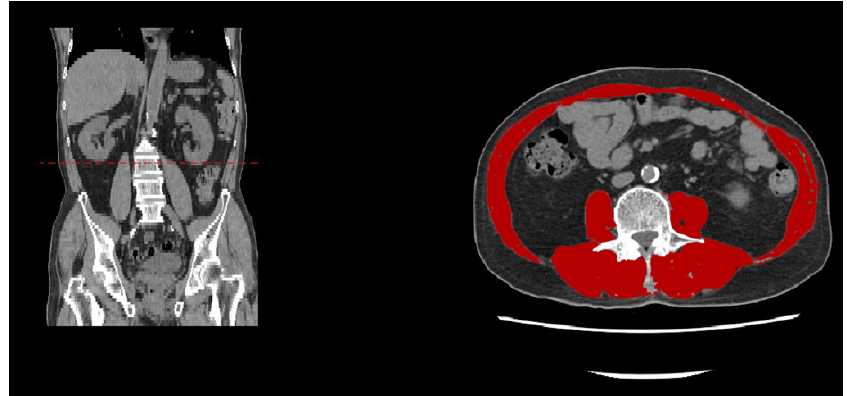
Figure 2. Computed tomography image of the third lumbar vertebral level. The following skeletal muscles are outlined in red: psoas, paraspinal, transverse abdominal, external oblique, internal oblique, and rectus abdominis muscles.